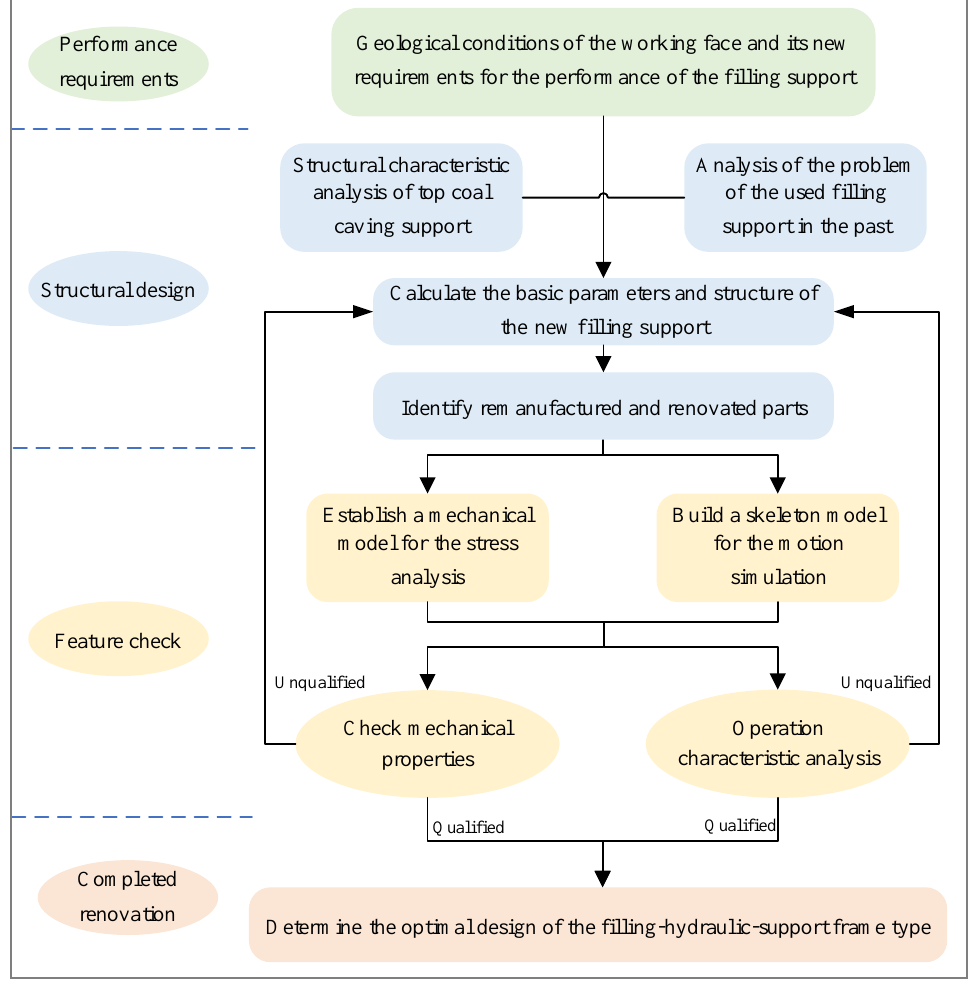
Figure 4. Design flow of refitting the backfilling hydraulic support in the top-coal caving hydraulic support.